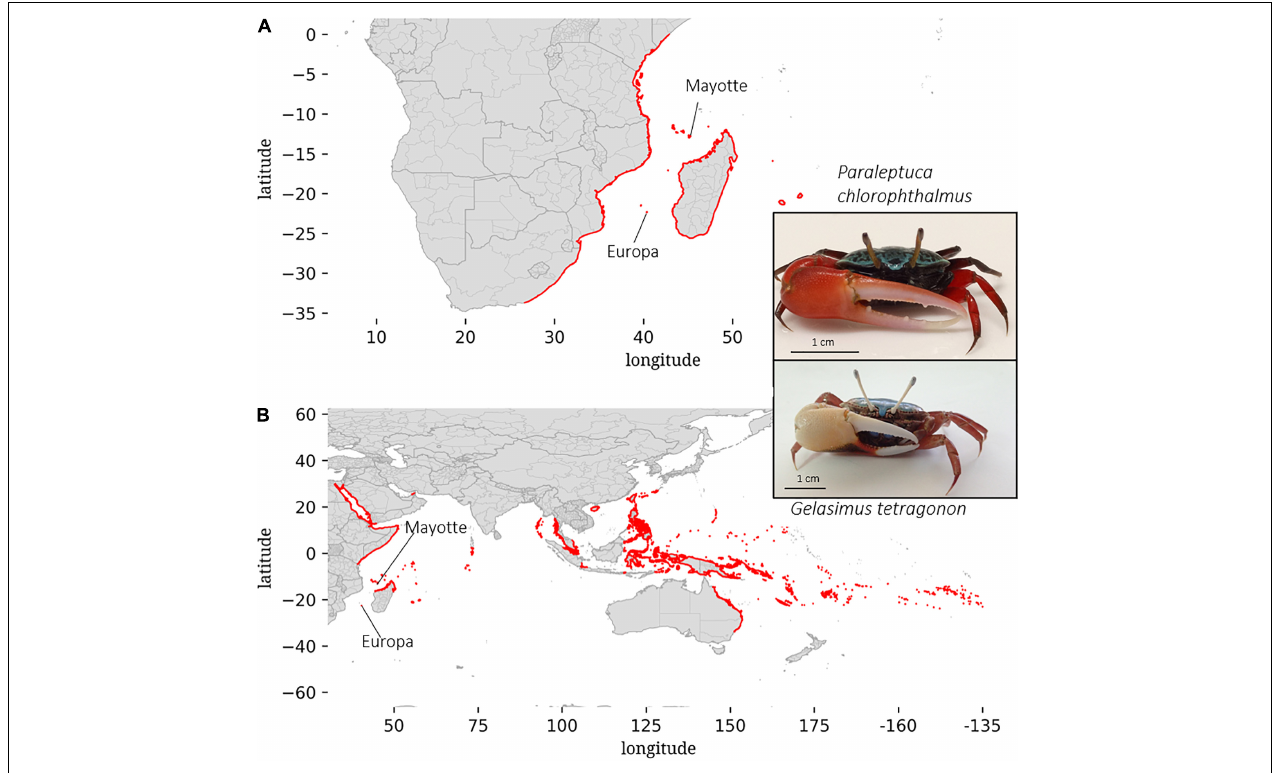
FIGURE 1 | Geographical ranges (in red) and pictures of the two studied species: Paraleptuca chlorophthalmus (A) and Gelasimus tetragonon (B) . Data was generated from the cybertaxonomy database described in Rosenberg (2014) and from the website: